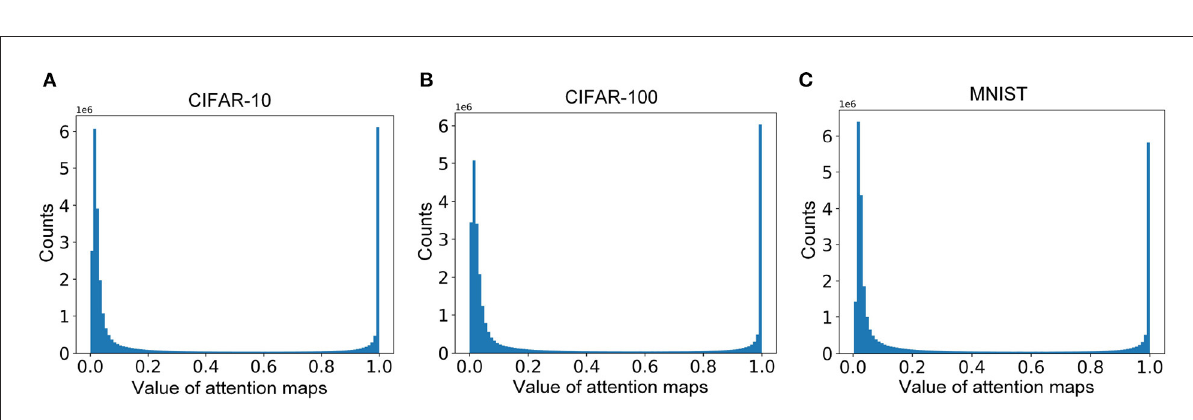
FIGURE3 (A–C) The distributions of the attention maps for samples in CIFAR-10, CIFAR-100, and MNIST,